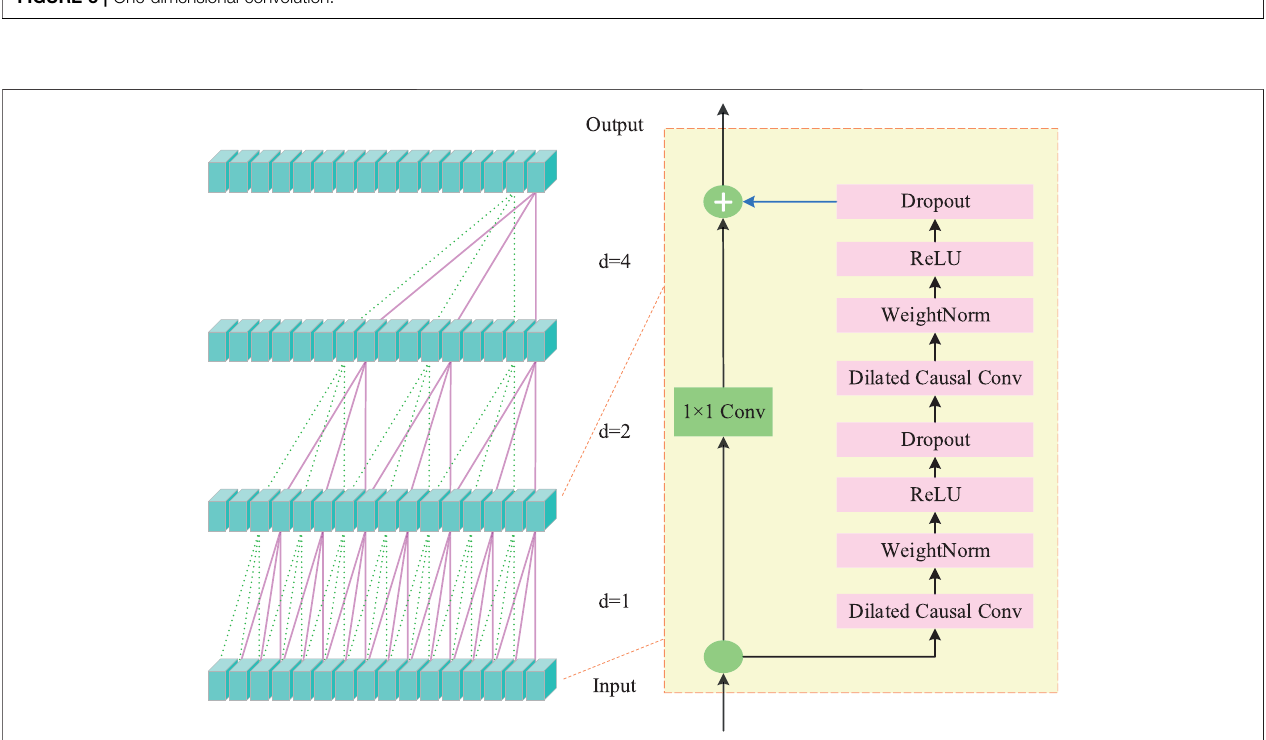
FIGURE 4 | Capacity degradation curves for B0005, B0007, and